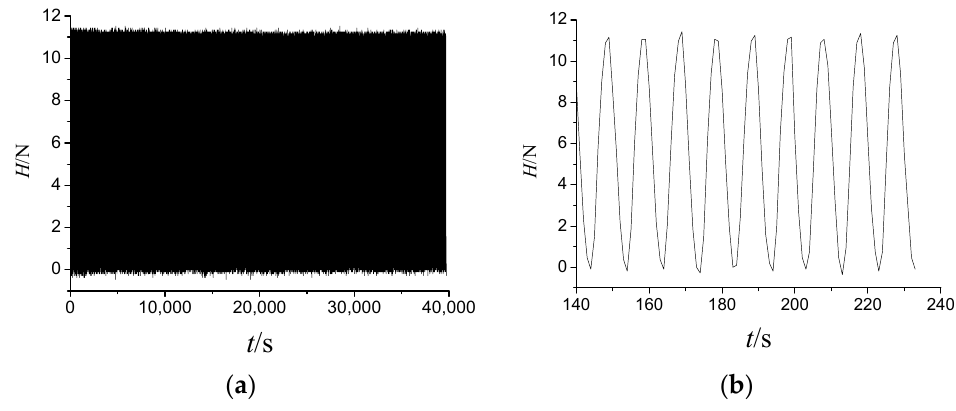
Figure 2. Output load curves of the cyclic loading device: ( a ) whole range; ( b ) initial stage. A non-contact miniature laser displacement sensor was mounted on a fixed support frame to measure the lateral displacements of the pile shaft at a height of 90 mm above the soil surface, as shown in Figure 1c. It has a range of 0–30 mm and an accuracy of 0.1%.